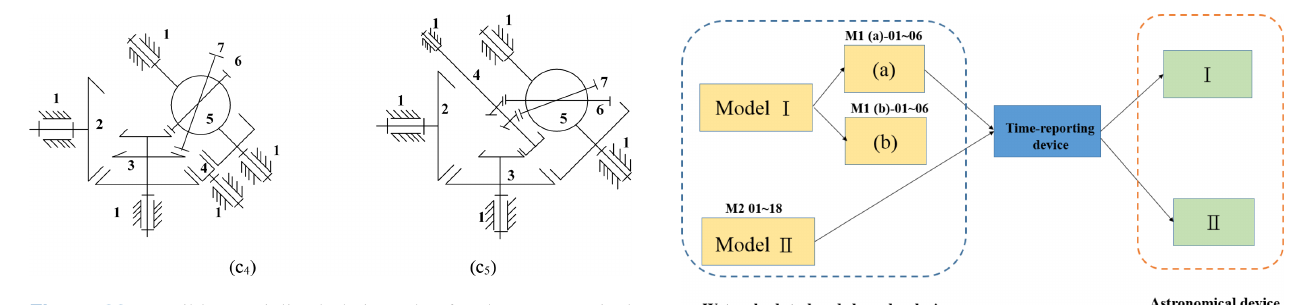
Figure 23. Feasible specialized chains atlas for the astronomical device.